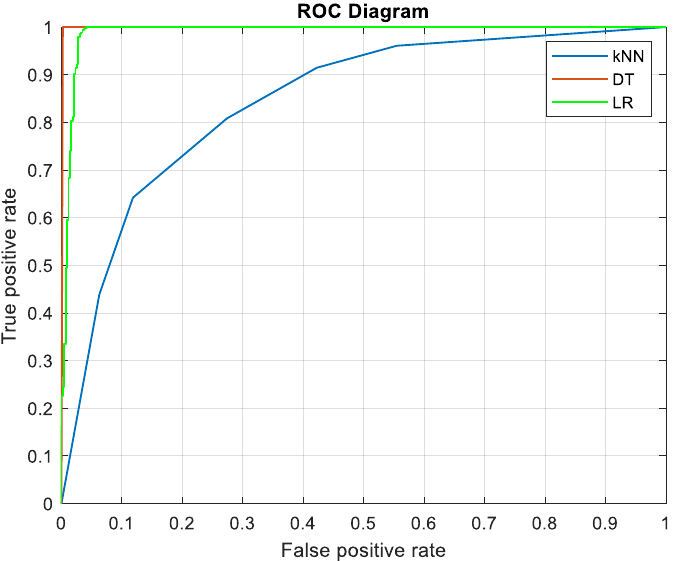
Figure 16. ROC diagram of the prediction result for k-nearest neighbors (kNN), decision tree (DT) and logistic regression (LR) methods.